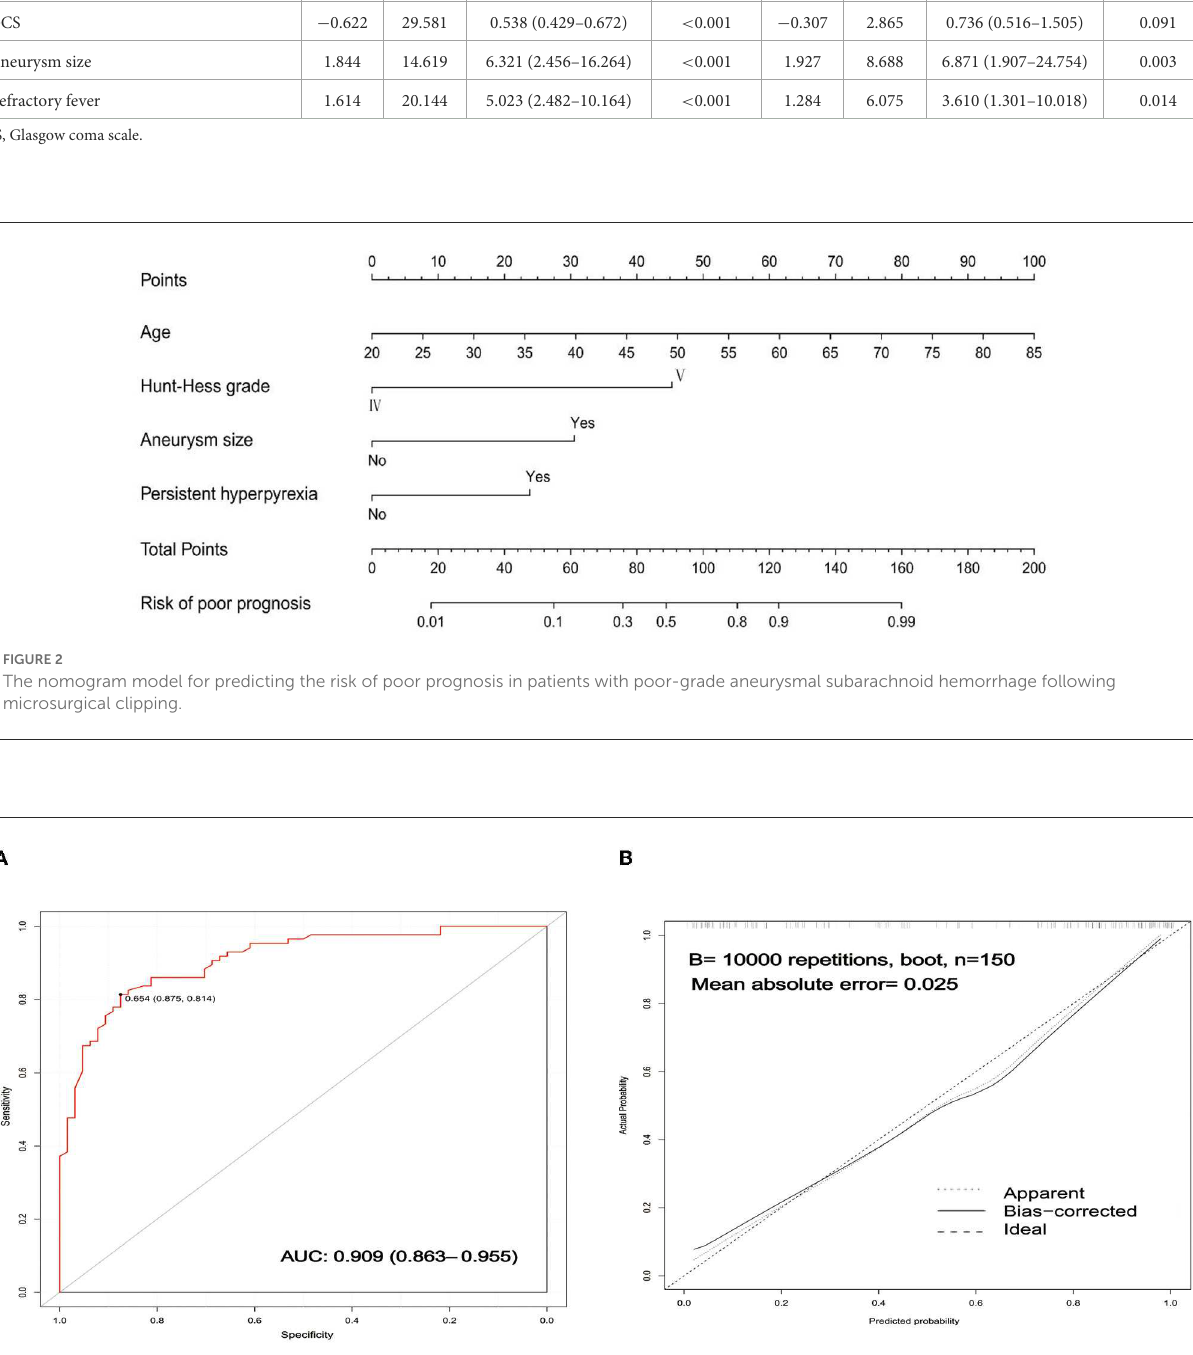
FIGURE3 Validation of the nomogram. (A) ROC curves of the nomogram for predicting the risk of poor prognosis. The AUC of the nomogram was 0.909 (95% CI: 0.863–0.955). (B) Calibration curves of the nomogram for predicting the risk of poor prognosis. ROC, receiver operating characteristic; AUC, area under